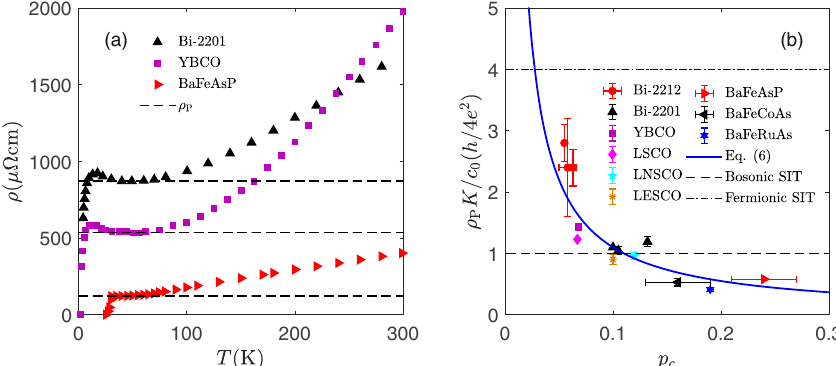
Fig. 5 Critical resistance near the antiferromagnetism – superconductivity transition. a The temperature ( T ) dependence of the resistivity ( ρ ). The symbols represent experimental values with a low-temperature plateau ( ρ P , dashed lines) near critical doping, determined from previously reported measurements 48,49,54 . b Critical sheet resistance of the plateau. The symbols represent the plateau values determined from previously reported experimental data 48,54,95 – 99 (see Supplementary Note 5), where K is the number of Cu or Fe ions in one unit cell, c 0 is the c -axis lattice constant, h / e 2 is the quantum resistance unit. The vertical errors are estimated from the plateau-determination uncertainty, and the horizontal errors are estimated from the concentration-determination uncertainty. The solid blue line represents the prediction from Eq. (6) with the scattering parameter γ (cid:2) densities and lattice constants 54,93,96,98,100 – 102 . The root mean squared error of the solid blue line is 0.4 h /4 e 2 . The dashed and the dash-dotted lines represent the Boson and Fermion localization theories for the SI transition (SIT) 55